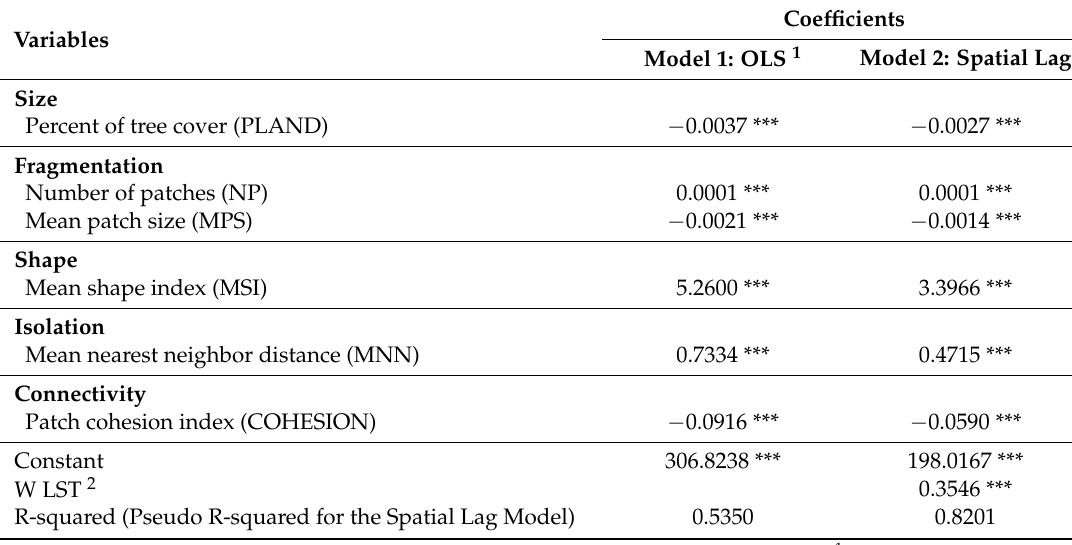
Table 4. LST estimation results ( n =